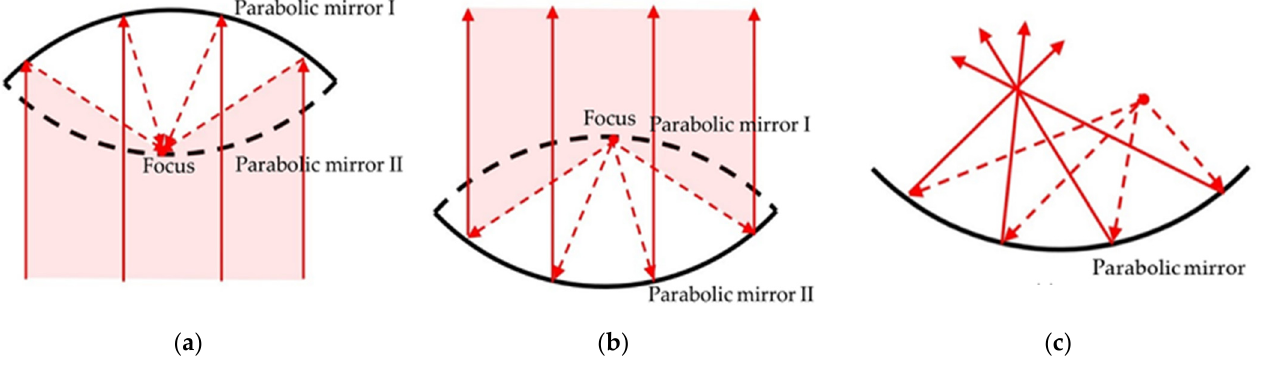
Figure 4. ( a ) The track of the light rays that focuses on the focus; ( b ) the track of the light rays reflected from the focus; ( c ) the track of the light rays from a source on the right side focusing on the left.